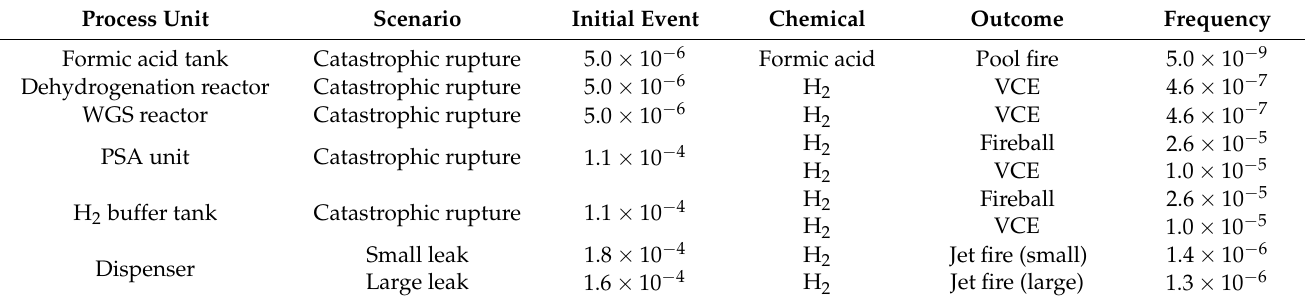
Table 3. Frequency analysis results for the FAHRS system.